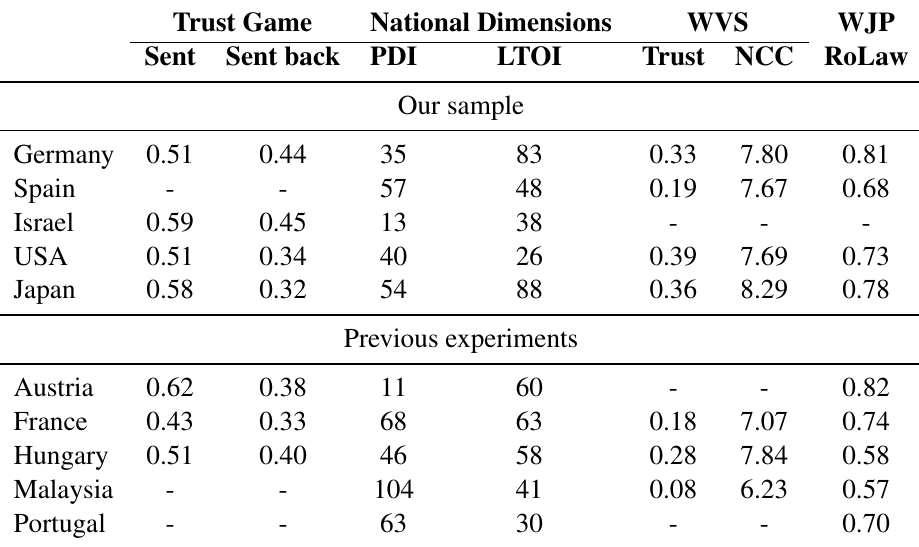
Table A1. Socio-economic